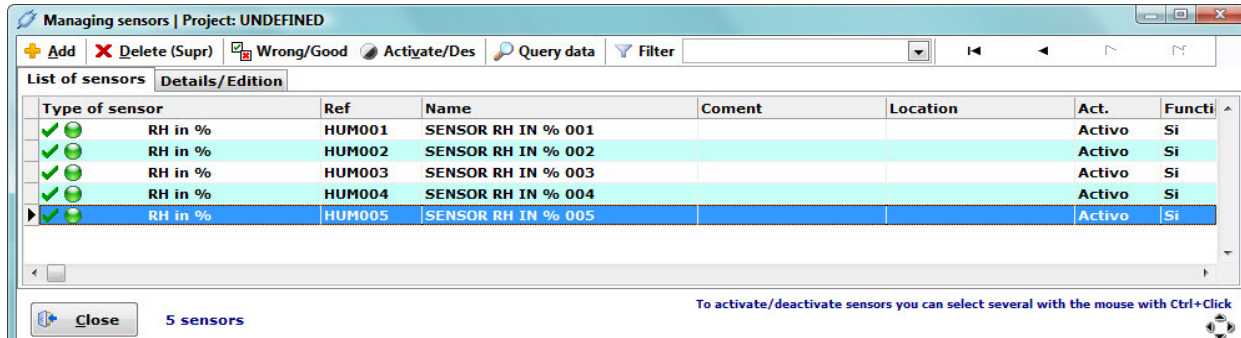
Figure 4. Sensors management window.